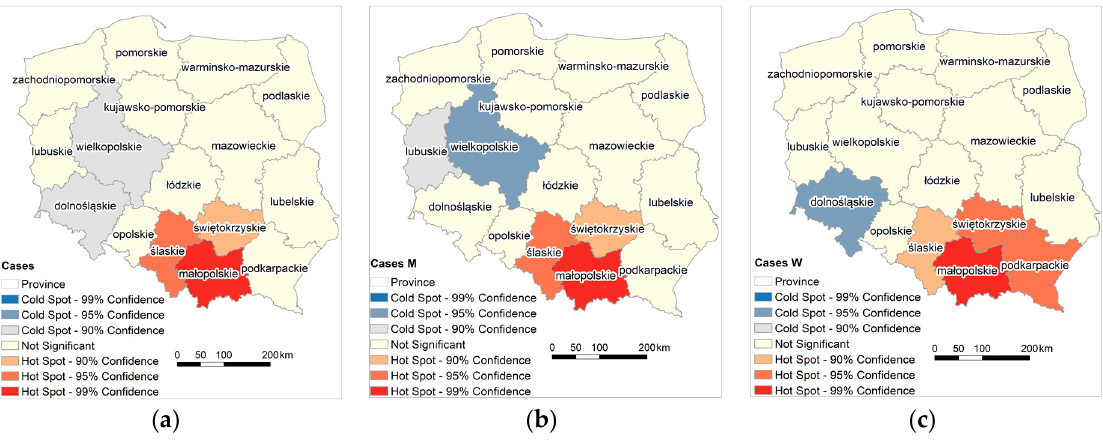
( c ) Figure 6. Local autocorrelation of MM morbidity rate in provinces; ( a ) cases all; ( b ) cases M; ( c ) cases W. MM mortality rates were derived from the WHO Mortality Database [70] and differ among countries. The highest mortality rate is denoted for the UK, Italy, and Belgium. Incidence of MM in men and women differs significantly (Figure 7). Compared to Western European countries, Poland has the lowest mortality rate.